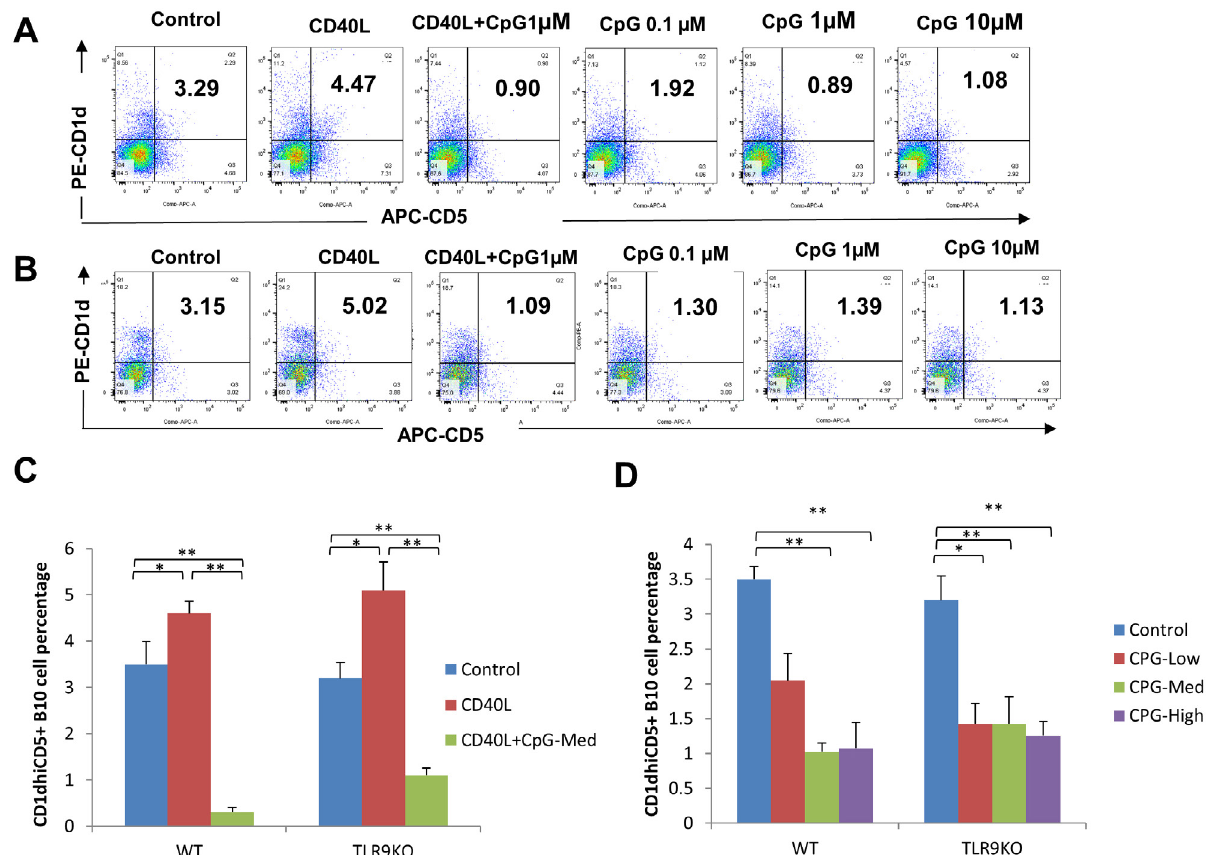
Figure 3- CpG reduced CD1d hi CD5 + B cell percentages in spleen B cells from WT and TLR9 KO mice. The percentages of CD1d hi CD5 + B cells were detected by flow cytometry from purified spleen B cells separated from WT mice (A) and TLR9 KO mice (B) cultured with CD40L (0.1 μg/ml), CpG (1 μM)+CD40L (0.1 μg/ml), CpG-Low (0.1 μM), CpG-Med (1 μM) and CpG-High (10 μM) for 48 h. The percentages of CD1d hi CD5 + B cells were analyzed and compared between groups including control, CD40L and CpG+CD40L (C) and groups including CpG-Low, CpG-Med and CpG-High (D) (mean±SD, n=4 WT mice or TLR9 KO mice per group, *p<0.05,